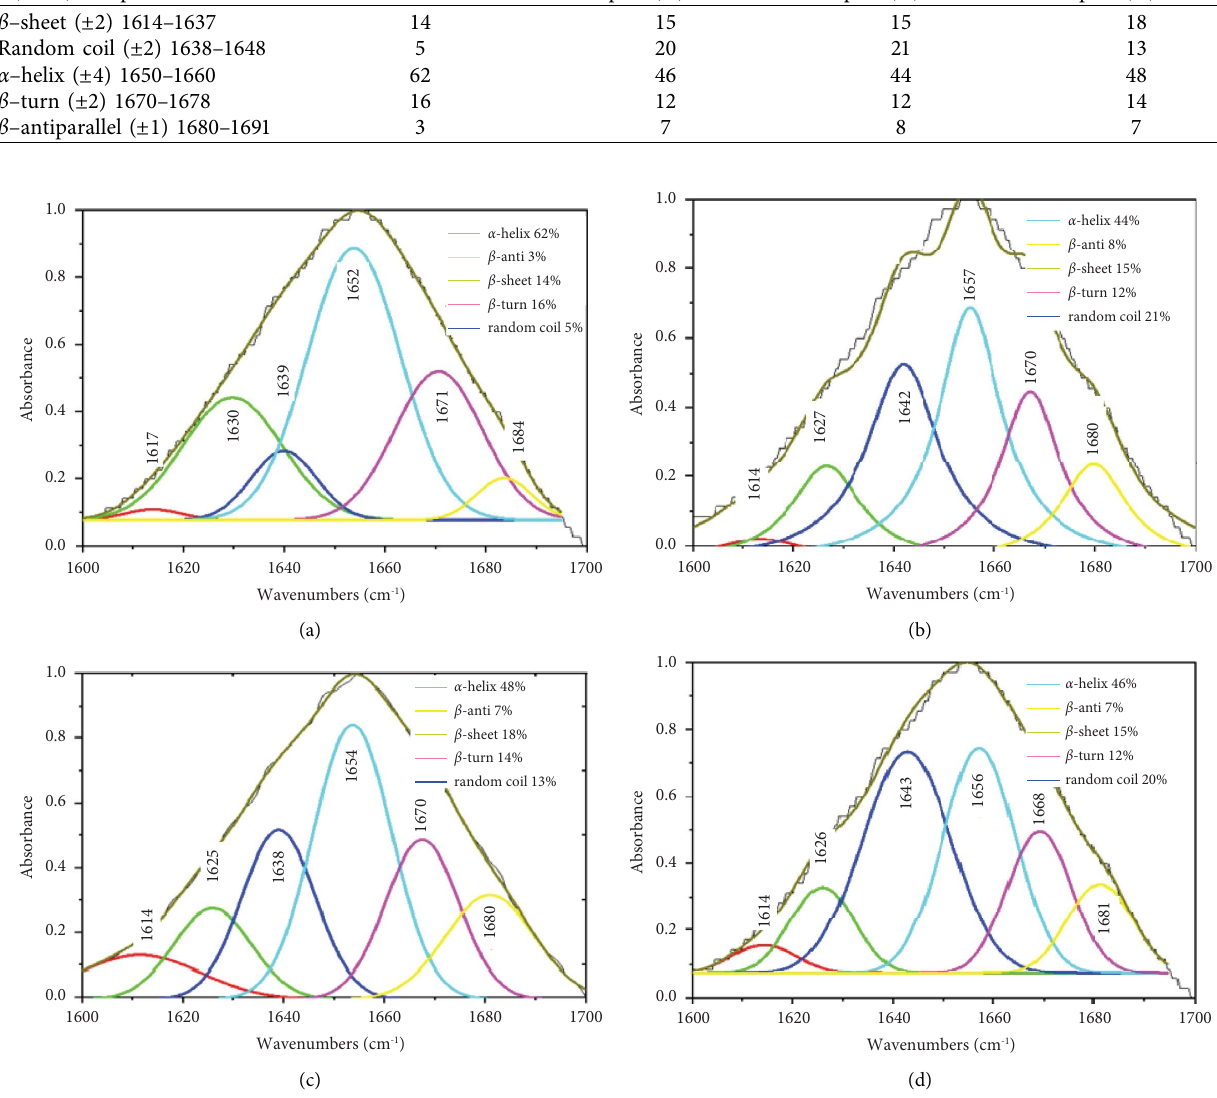
Figure 3: For (a) free BSA, curve ftted amide I at 1700–1600cm − 1 ( R 2 � 0.99). (b) BSA-Cu + . (c) BSA-Ni +2 . (d) complexes of BSA-Al +3